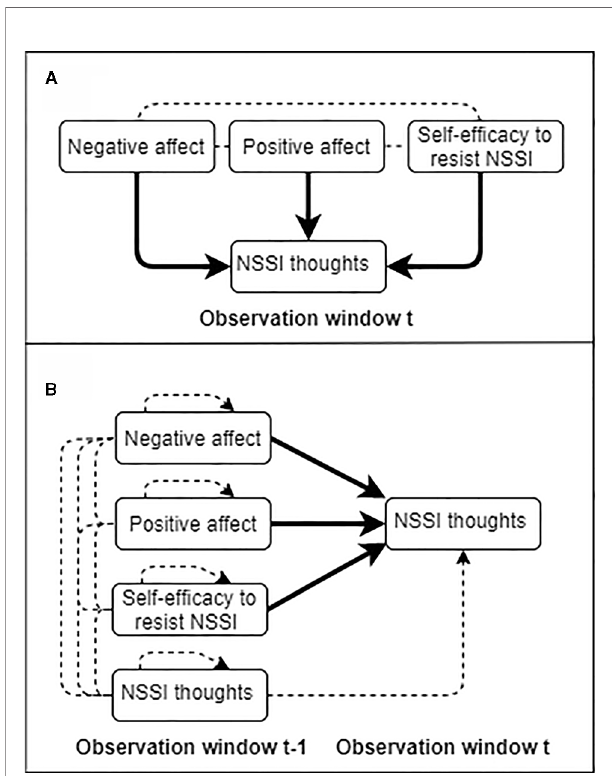
FIGURE 1 | Graphical illustration of the fi rst research objective of the study in which NSSI thoughts are predicted within (Objective 1a depicted in panel A ) and across measurement windows (Objective 1b depicted in panel B ) at the within-person level. Solid arrows indicate effects of interest. Dotted arrows represent autoregressive effects and dotted lines associations within the same observation